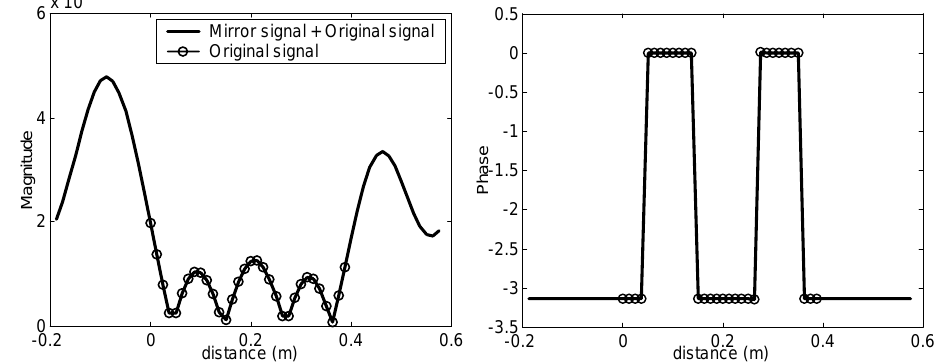
Fig. 4. Magnitude (left) and phase (right) of the complex-displacement signal v ( x ) of a beam with free-free boundary excited by a harmonic point force. The calculation frequency is 500 Hz. The continuous and periodic displacement signal (solid line) is built from the original displacement signal (o-o-o-o) using a cosine link